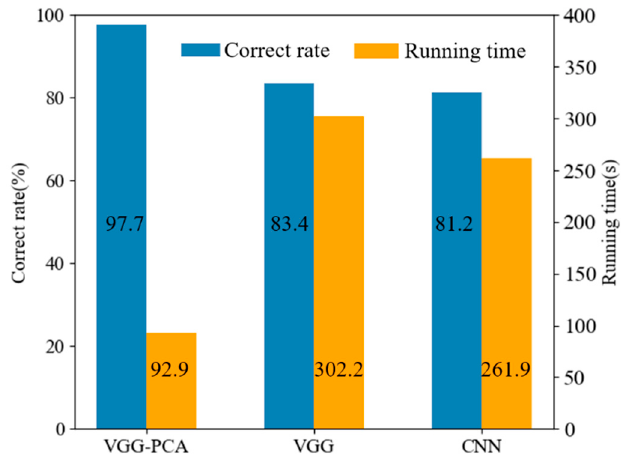
Figure 7. Performances of fault diagnosis of three